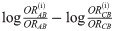
Bland-Altman plot.The differences between the AB and CB approaches in terms of log OR changes after omission of trials, i.e., logORAB(i)ORAB−logORCB(i)ORCB, is drawn agaist the mean, i.e., 12(logORAB(i)ORAB+logORCB(i)ORCB). The mean difference and 95% limits of agreement are shown in dashed lines. Four networks are highlighted in color.